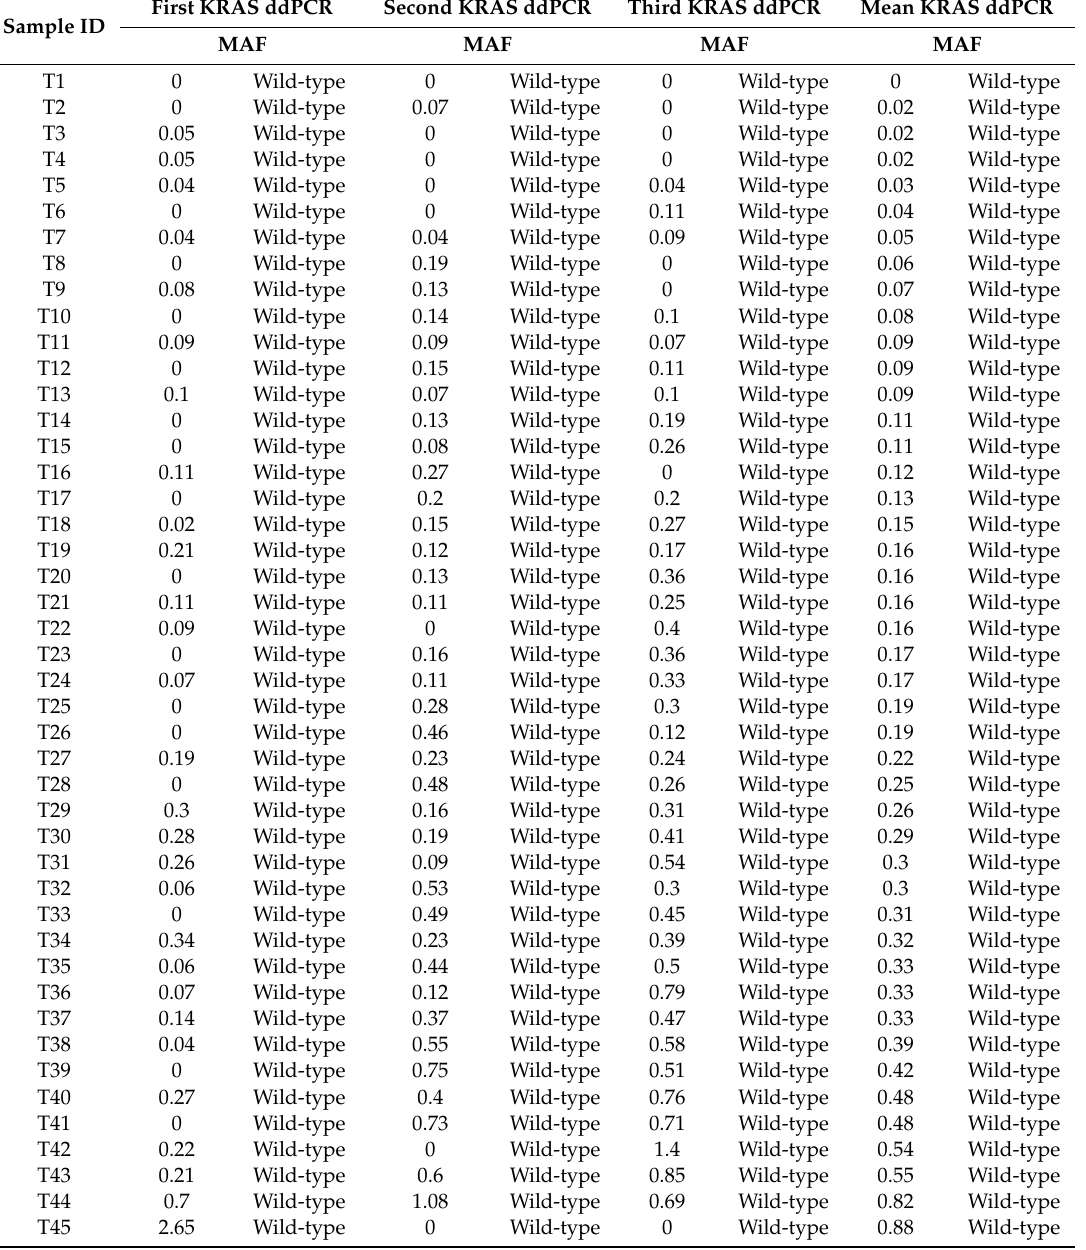
Table 2. Repeated KRAS G12 / 13 mutation detection in CRAC tissue by